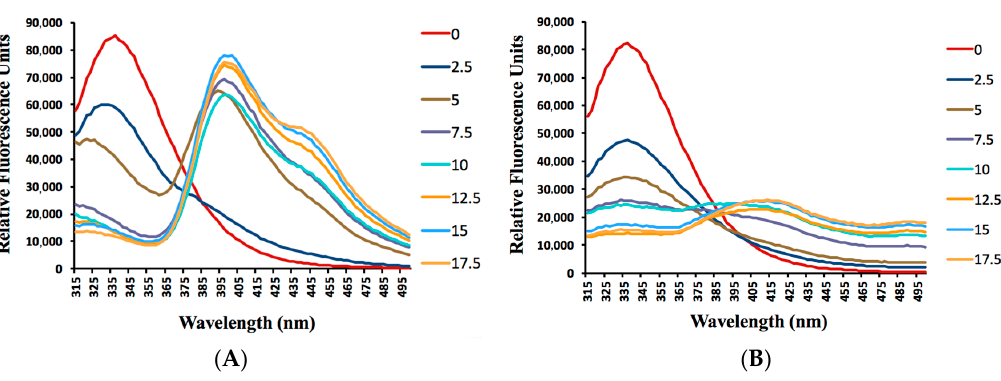
Figure 5. The effects of CM14 ( A ) and CM15 ( B ) on the fluorescence spectra of BSA at 22 °C. ex = 295